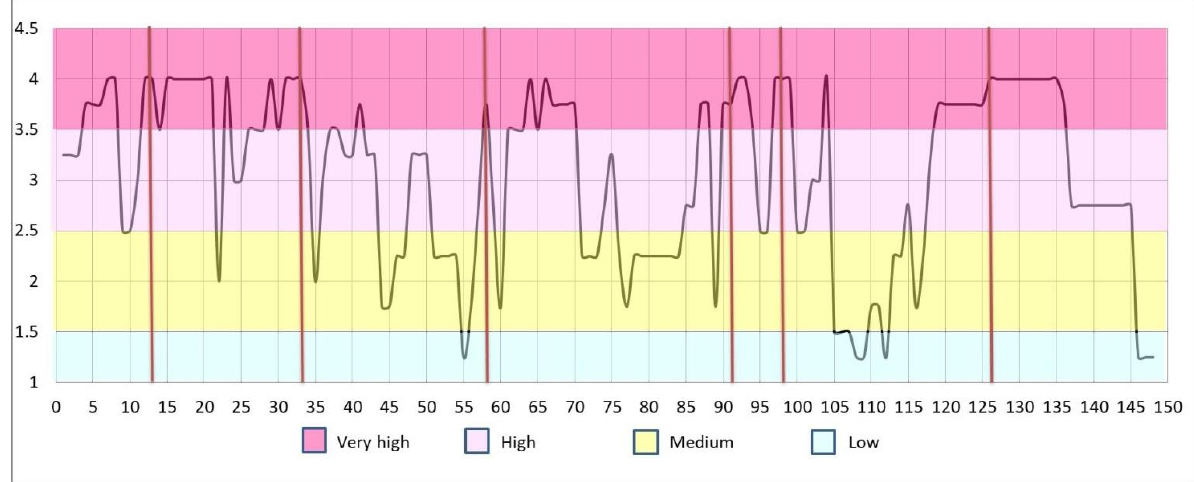
Figure 7. Physical erosion vulnerability of the Basilicata territory. The vertical lines represent the limit of the macro-areas. ( CeD values: <1.5: low, 1.50–2.50: medium, 2.50–3.50: high and >4: very high